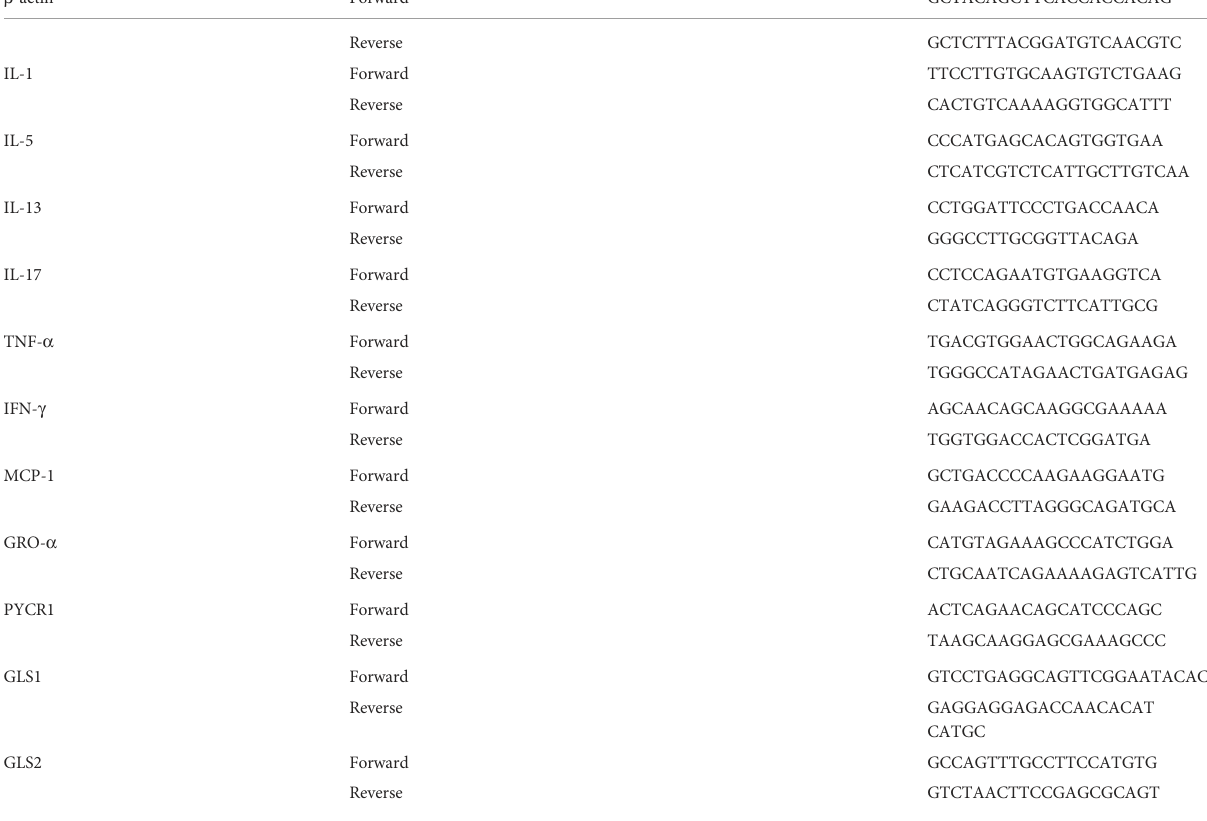
TABLE 2 Primer sequences form RNA analysis by real-time